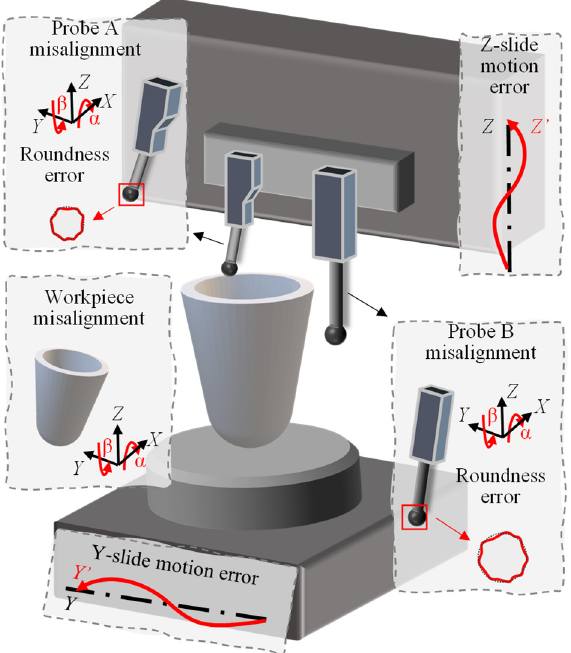
Figure 4. Schematic of the misalignment, roundness errors and motion errors associated with the measurement system.